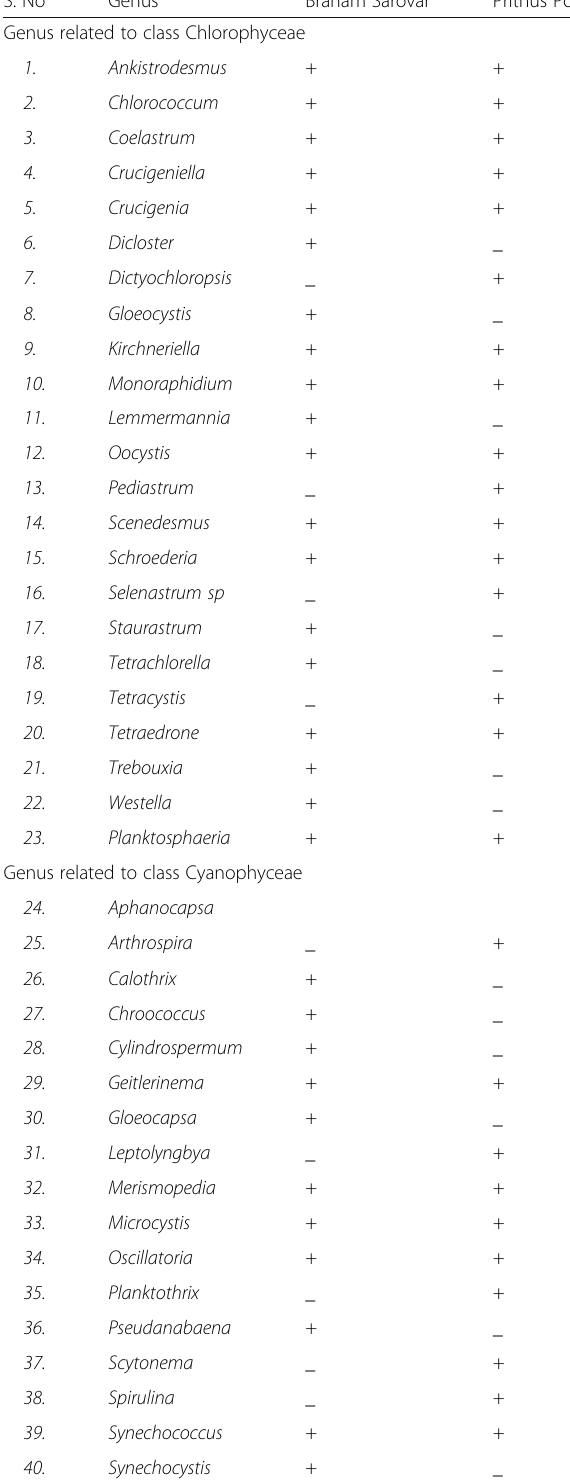
Table 6 List of genera observed in Braham Sarovar and Prithus Pools